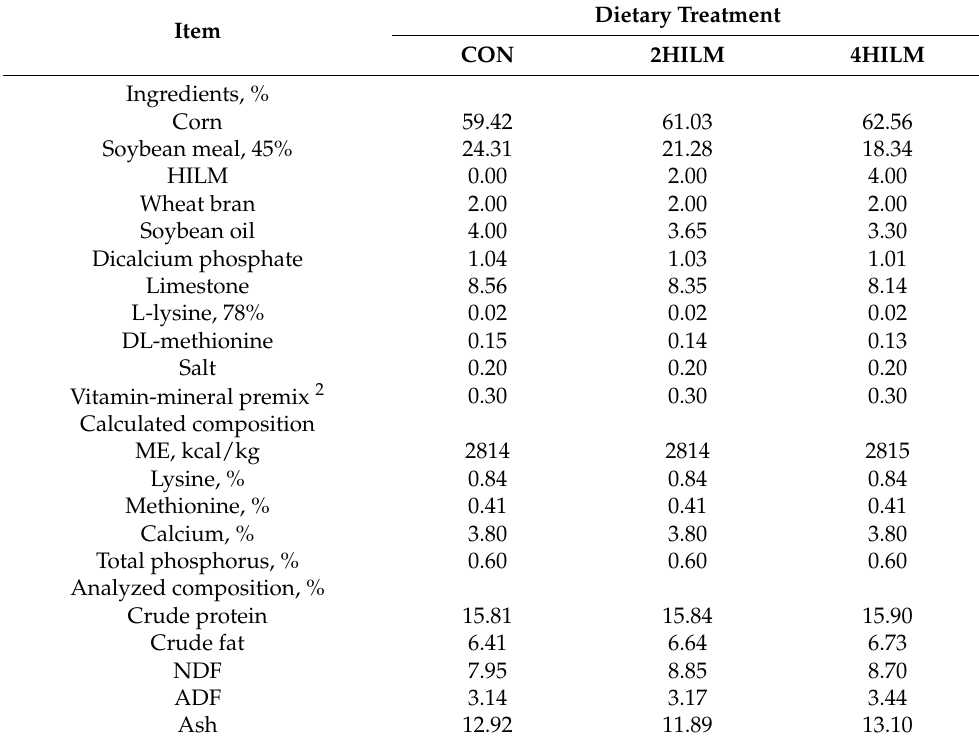
Table 1. Ingredients and chemical composition of the experimental laying hens’ diets containing different levels of Hermetia illucens larvae meal (HILM) 1